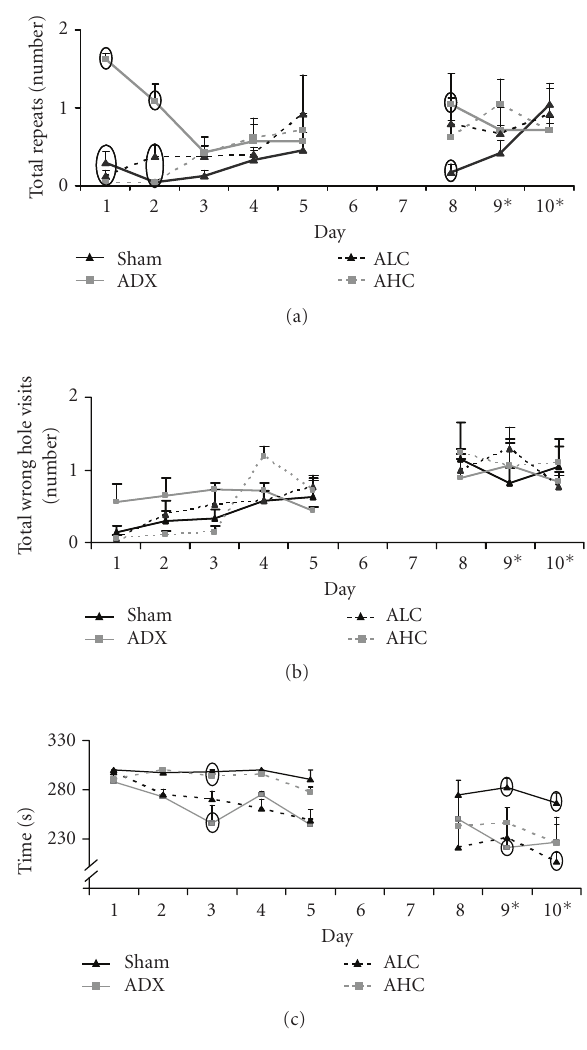
Figure 2: (a) Working memory expressed as number of holes revis- ited. (b) Reference memory expressed as visits to nonbaited holes. (c) Time to finish the task, that is, to obtain all three baits or 5 min- utes, of sham (black line), ADX (grey line), ALC (striped black line), and AHC mice (striped grey line). Days 9 and 10 on the x -axis in- dicate removal of rings from all cylinders, while the bait remained in the same cylinders as before. Data present the mean of the three trials per day ± SEM. Ovals mark data points with significant dif- ferences P < . 05 between groups within